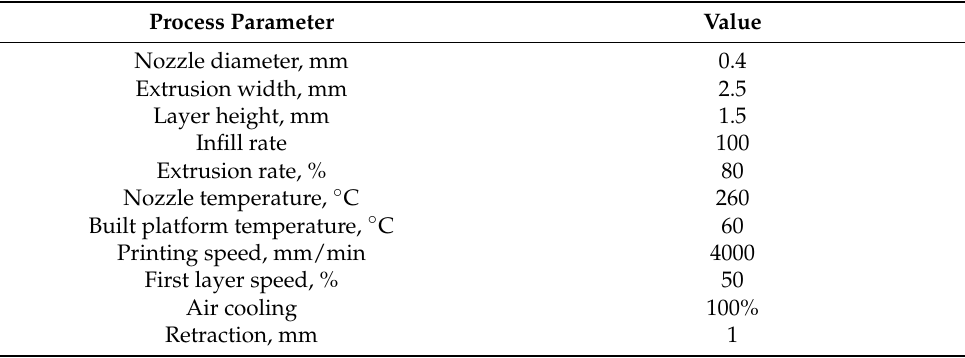
Table 3. AM and slicing process parameters for PETG foaming.